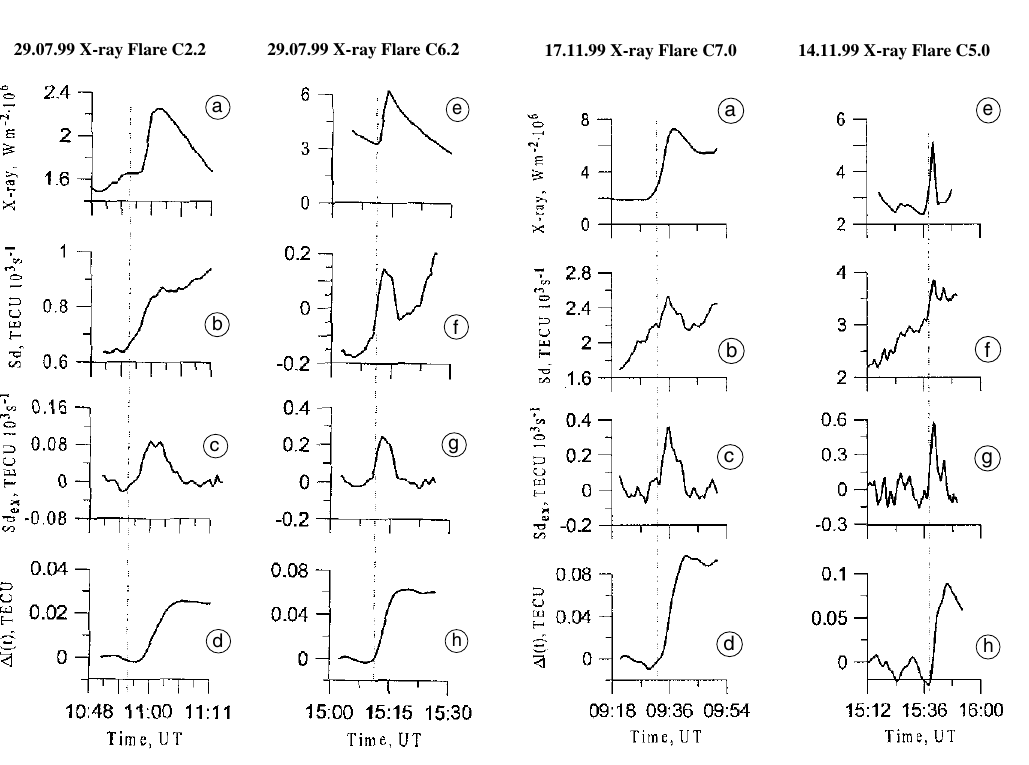
Fig. 3a-h. Faint solar flare November 17, 1999 (C7.0/ 1N, 09:38 UT, S15W53) (a-d); soft X-ray emission flux (GOES-10) in the range 1-8 Å (a); normalized result of a coherent summation Sd of the time derivatives of the TEC variations for all LOS (b); the same curve (b), upon subtracting the trend determined as a polynomial of degree 3 on the time interval 09:18- 09:54 UT (c); mean integral increment of TEC (d). Analogous dependencies for faint solar flare November 14, 1999 (C5.0, 15:40 UT) on panels